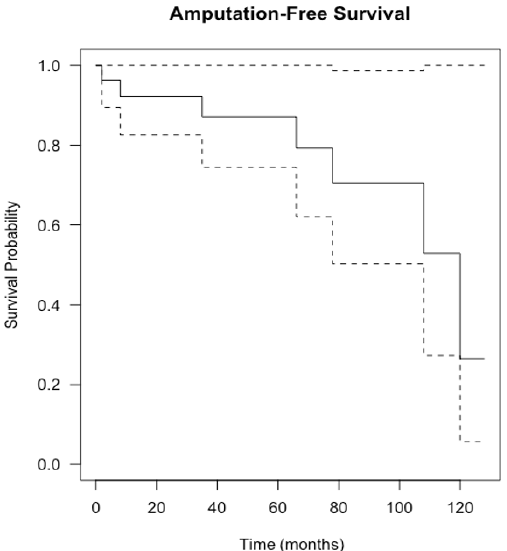
Figure 5. Kaplan–Meier curve showing amputation-free survival following knee revision surgery with gastrocnemius flap for infec- tion eradication. The dashed lines show 95% confidence